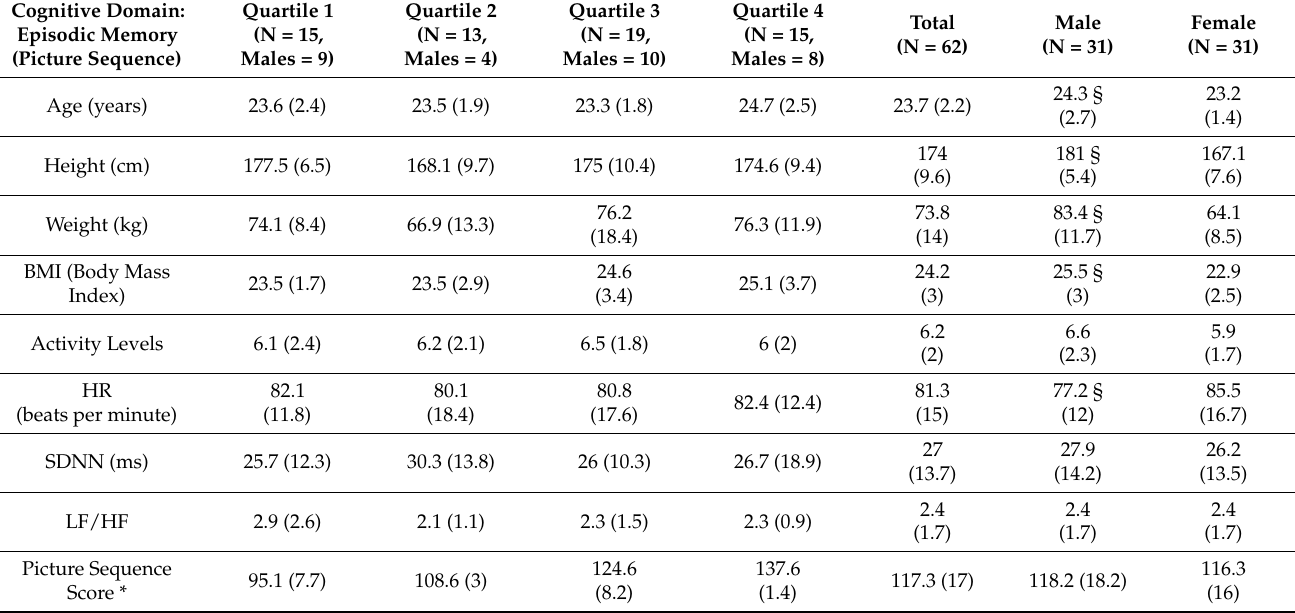
Table 1. Average (sd) age, height, weight, body mass index, activity levels, heart rate (HR), standard deviation of N–N interval (SDNN), low-frequency to high-frequency ratio (LF/HF), and picture sequence testing score shown for quartiles, total, males, and females. * = p < 0.05 for comparisons between the lower 50% and upper 50% of quartile, §: p < 0.05 of a comparison between males and females.